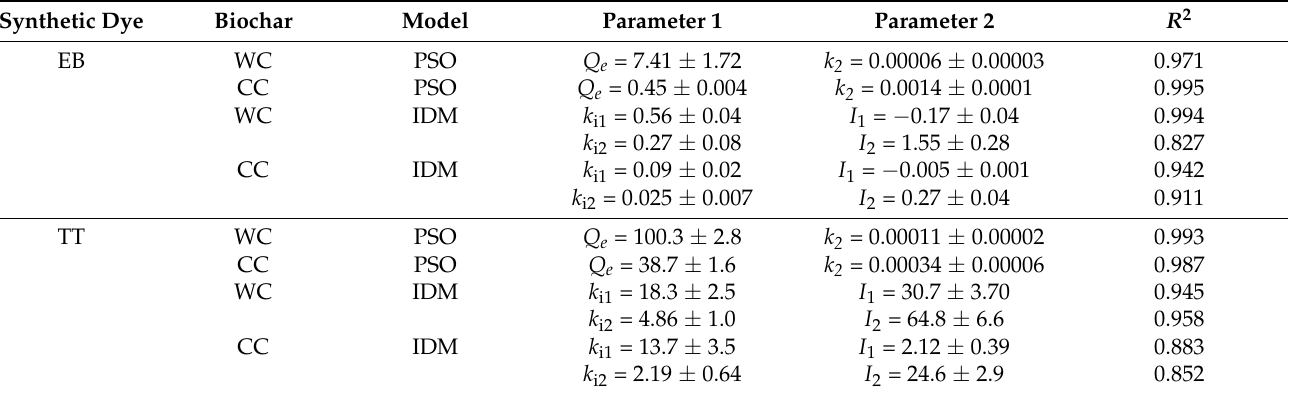
Table 3. Kinetic parameters of thioflavin T (C 0 = 100 mg g − 1 ) and erythrosine B (C 0 = 43 mg g − 1 ) adsorption for WC and CC biochars calculated from pseudo-second-order (PSO) and intraparticle diffusion (IDM) models using nonlinear regression